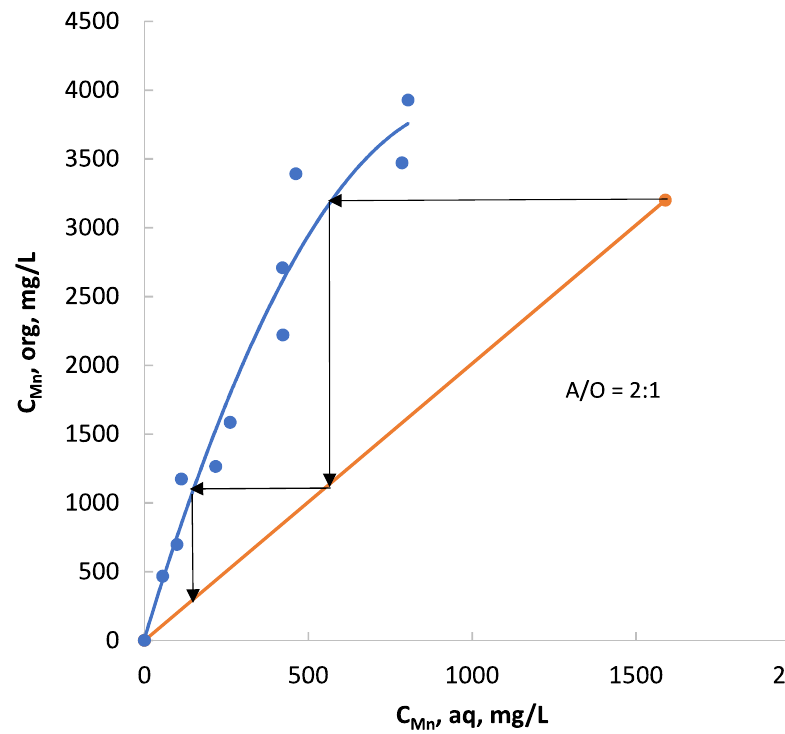
Figure 5. Mn loading isotherm in 0.8 M D2EHPA (pH of 3.1; 35 ◦ C) and an initial process design by McCabe-Thiele